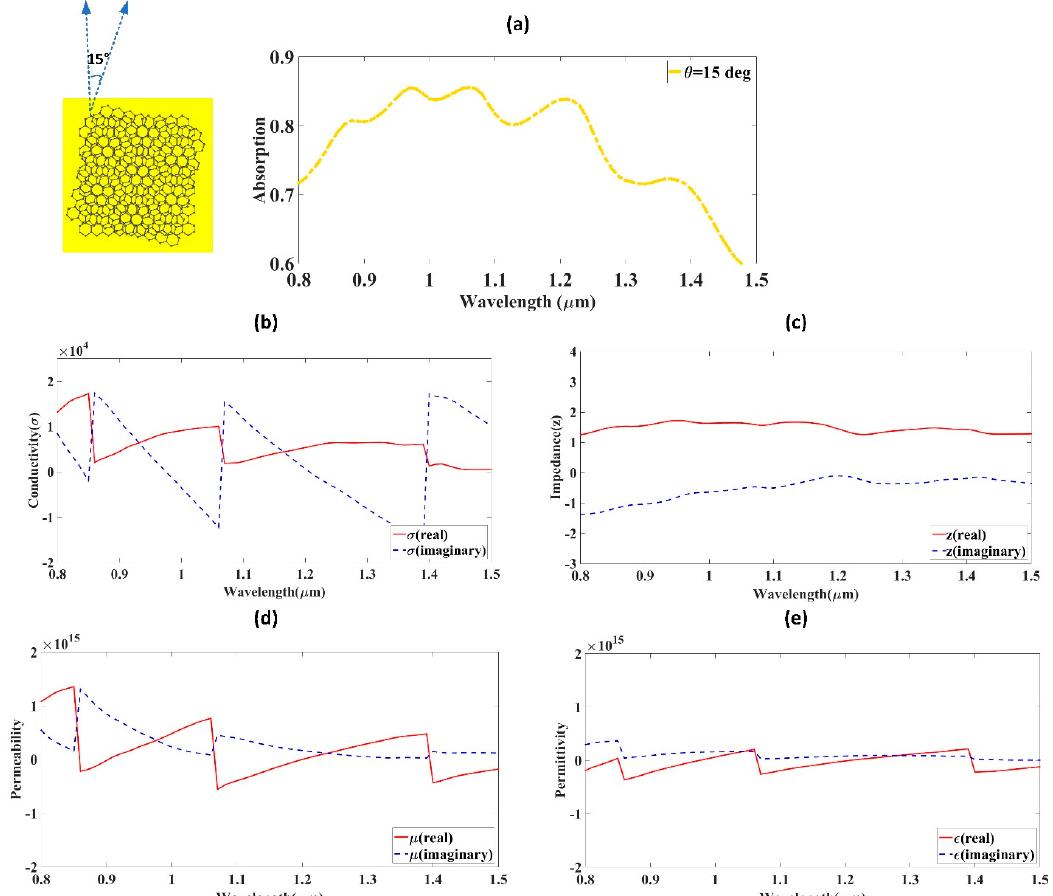
Figure 5. Bilayer graphene with twist angle of 15°. ( a ) Absorption; ( b ) conductivity (Re and Imag); ( c ) impedance (Re and Imag) ( d ) permeability (Re and Imag); ( e ) permittivity (Re and Imag). The inset figure shows the schematic of bilayer graphene with a twist of 15°.